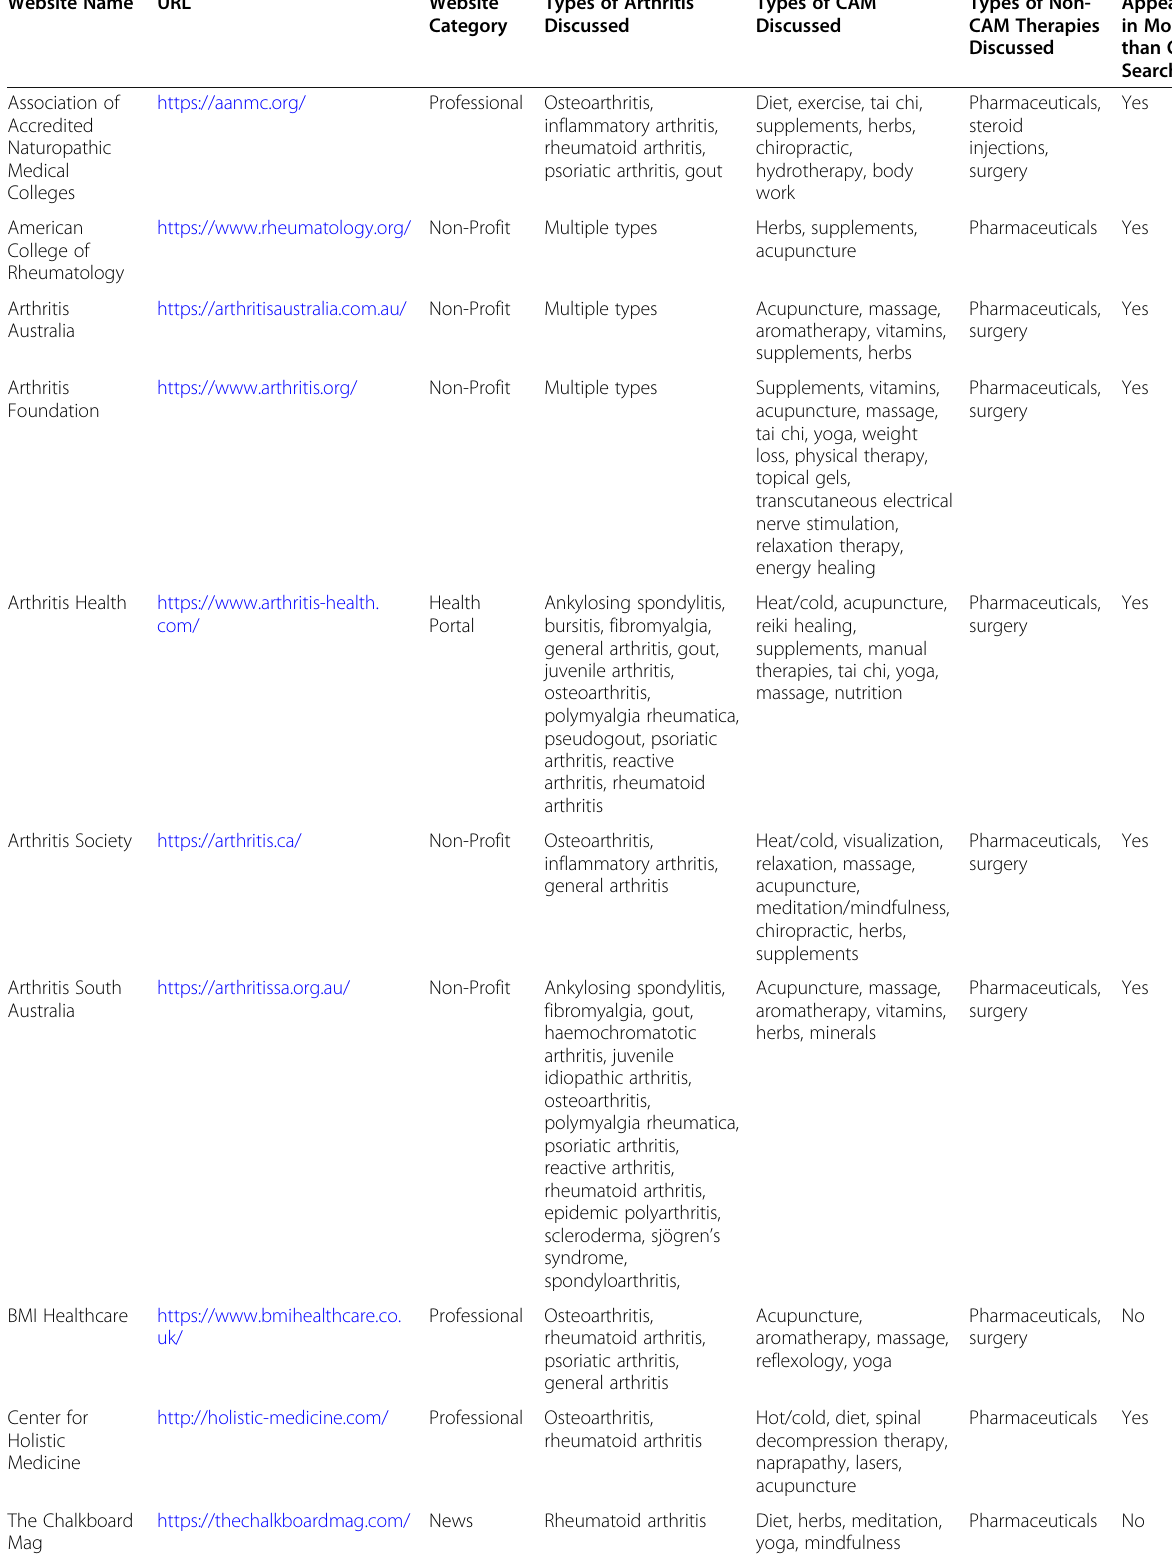
Table 1 General Characteristics of Eligible